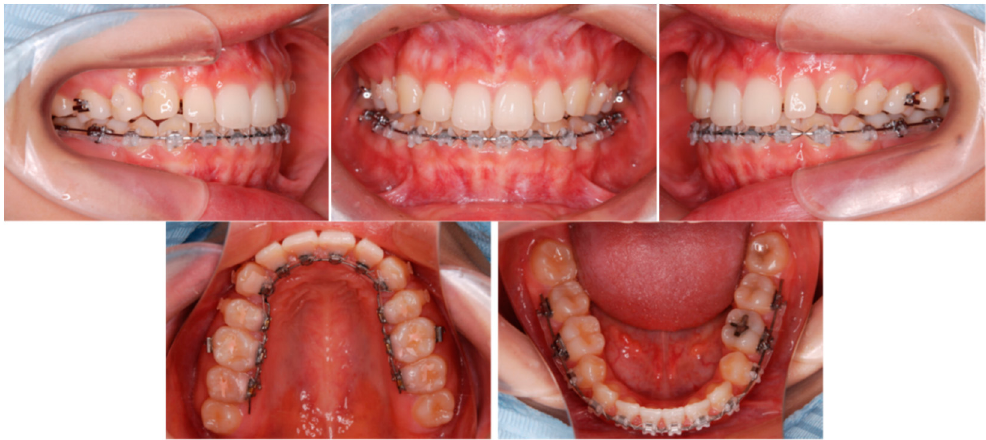
Figure 13. Progress intraoral photographs after 11 months of start of active treatment.